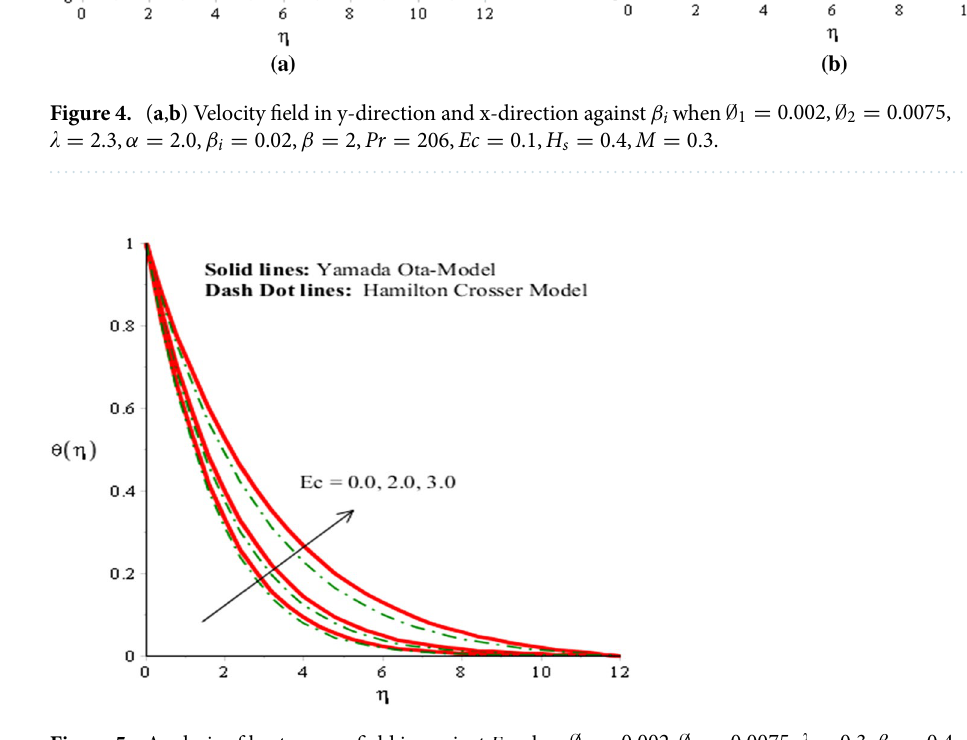
Figure 5. Analysis of heat energy field in against Ec when ∅ 1 = α = 3.0, β i = 2.0, β = 0.2, Pr = 206, H s = − 3.0, M =